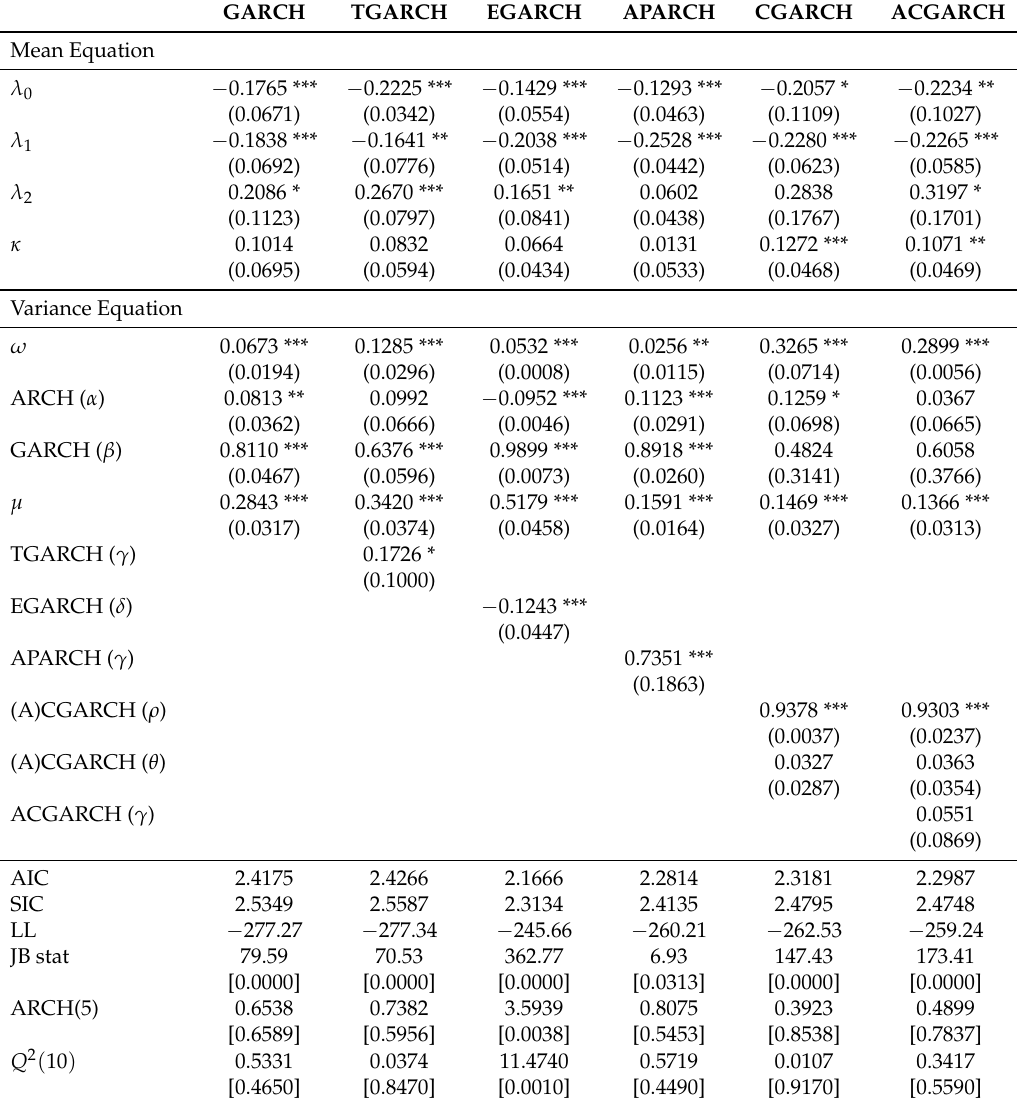
Table A12. GARCH-M Tests for Ripple for the recovery